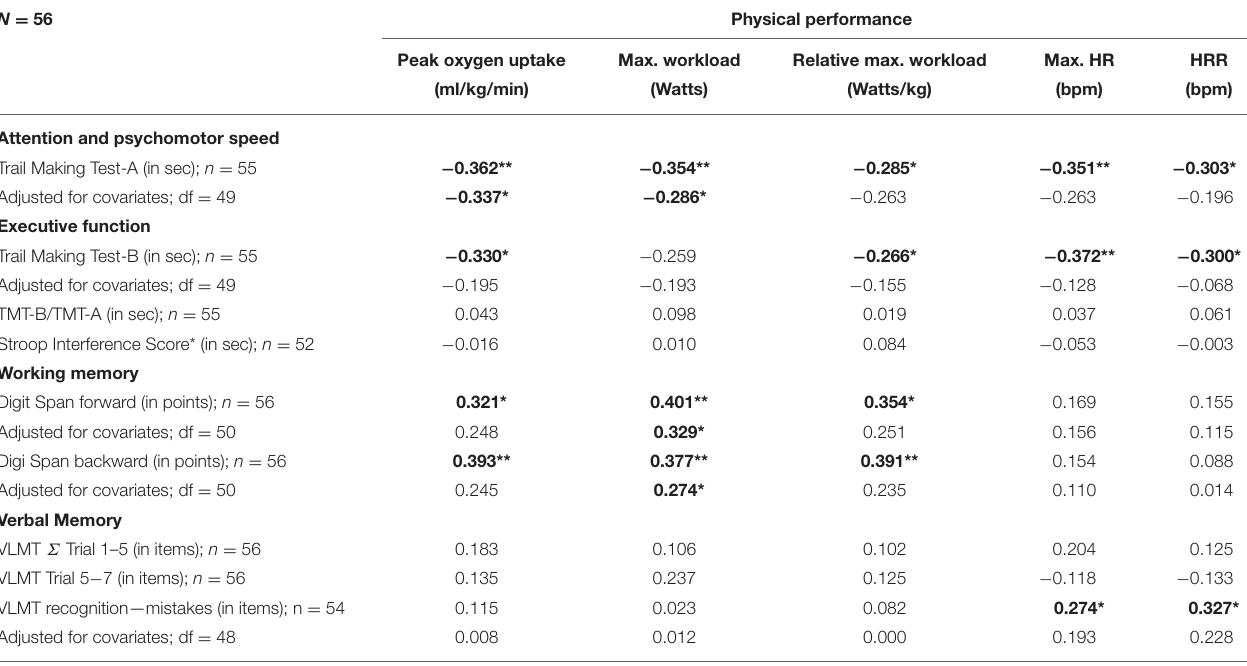
TABLE 3 | Bivariate Spearman and partial correlation between cognitive performance and physical performance. N =